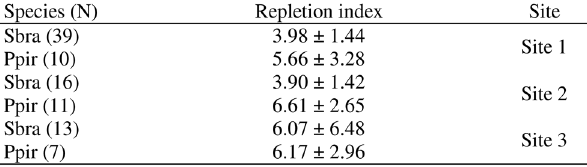
Fig. 3. Frequency of occurrence (%) of different food items determined by the analysis of the stomach content of Ser- rasalmus brandtii (a) and Pygocentrus piraya (b) collected between May 2001 and April 2003 according to the three sampling